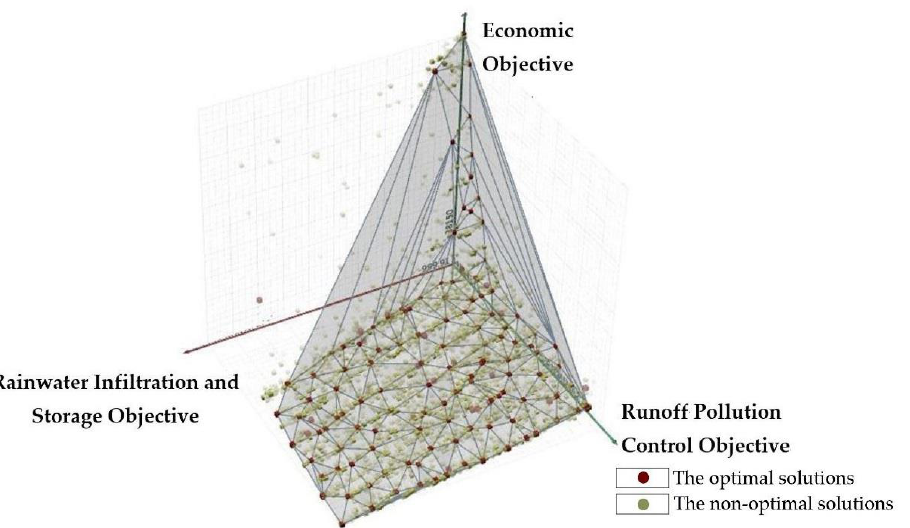
Figure 8. (a) Pareto front distribution of runoff pollution control (x-axis) and economic cost (y-axis);. (b) Pa- reto front distribution of rainwater infiltration and storage (x-axis) and economic cost (y-axis);(c) Pareto front distribution of runoff pollution control (x-axis) and rainwater infiltration and storage (y-axis)